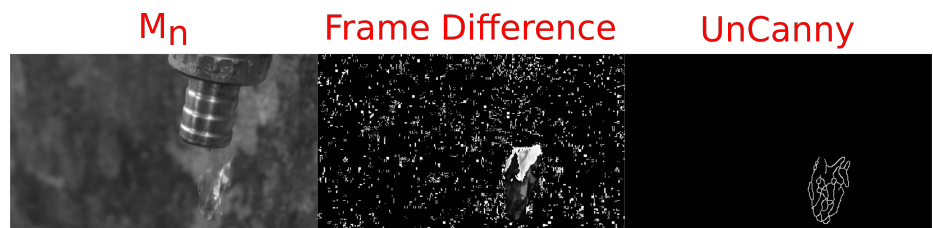
Figure 2. A wideo of water drops leaking from a faucet was processed with both a raw framewise difference and the UnCanny method. The leftmost image labeled M n shows the most recent frame of the video, using an 8-bit single-channel output. The middle image labeled “Frame Difference” visually depicts the results of a framewise subtraction and scaling of frames M n and M n − 1 . The rightmost image is the output of the UnCanny method. In all images, a single droplet was seen falling from the faucet; however, the UnCanny method results shows only the movement of the drop, without shot noise.